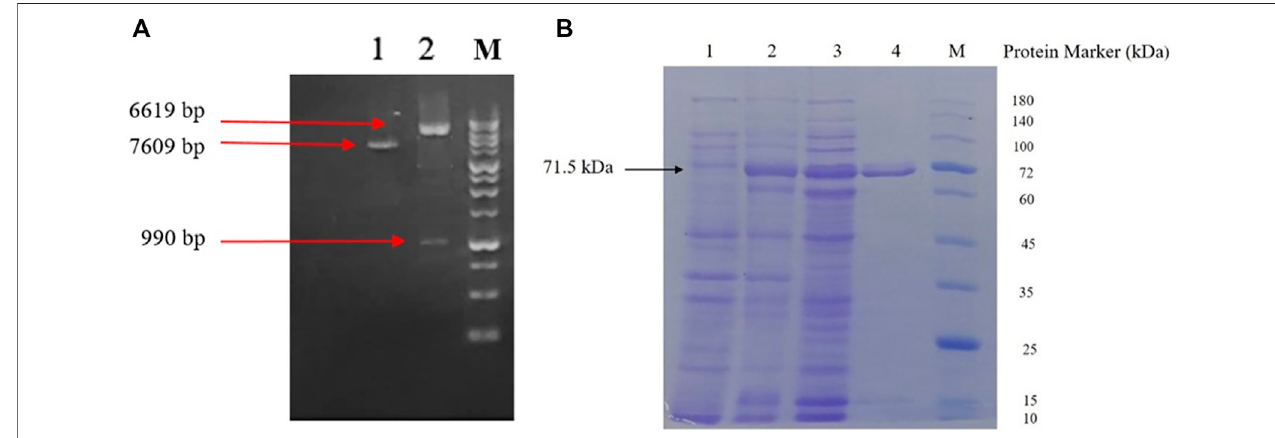
FIGURE 4 | (A) Agarose gel electrophoresis analysis; lane 1: undigested pMAL-c2X-D16F7 construct; lane 2: Double-digested pMAL-c2X-D16F7 plasmid showingcorrectsizeofplasmid,insertandM:DNAladder(GeneRuler ™ 1 kb). (B) SDS-PAGEanalysisofrecombinantMBP-D16F7scFvexpression;lane1:un-induced E. coli cells; lane 2: cell ’ s total proteins after auto-induction; lane 3: soluble proteins after auto-induction; lane 4: Ni-puri fi ed recombinant fusion protein; and M: protein marker (PM 1500, ExcelBand ™